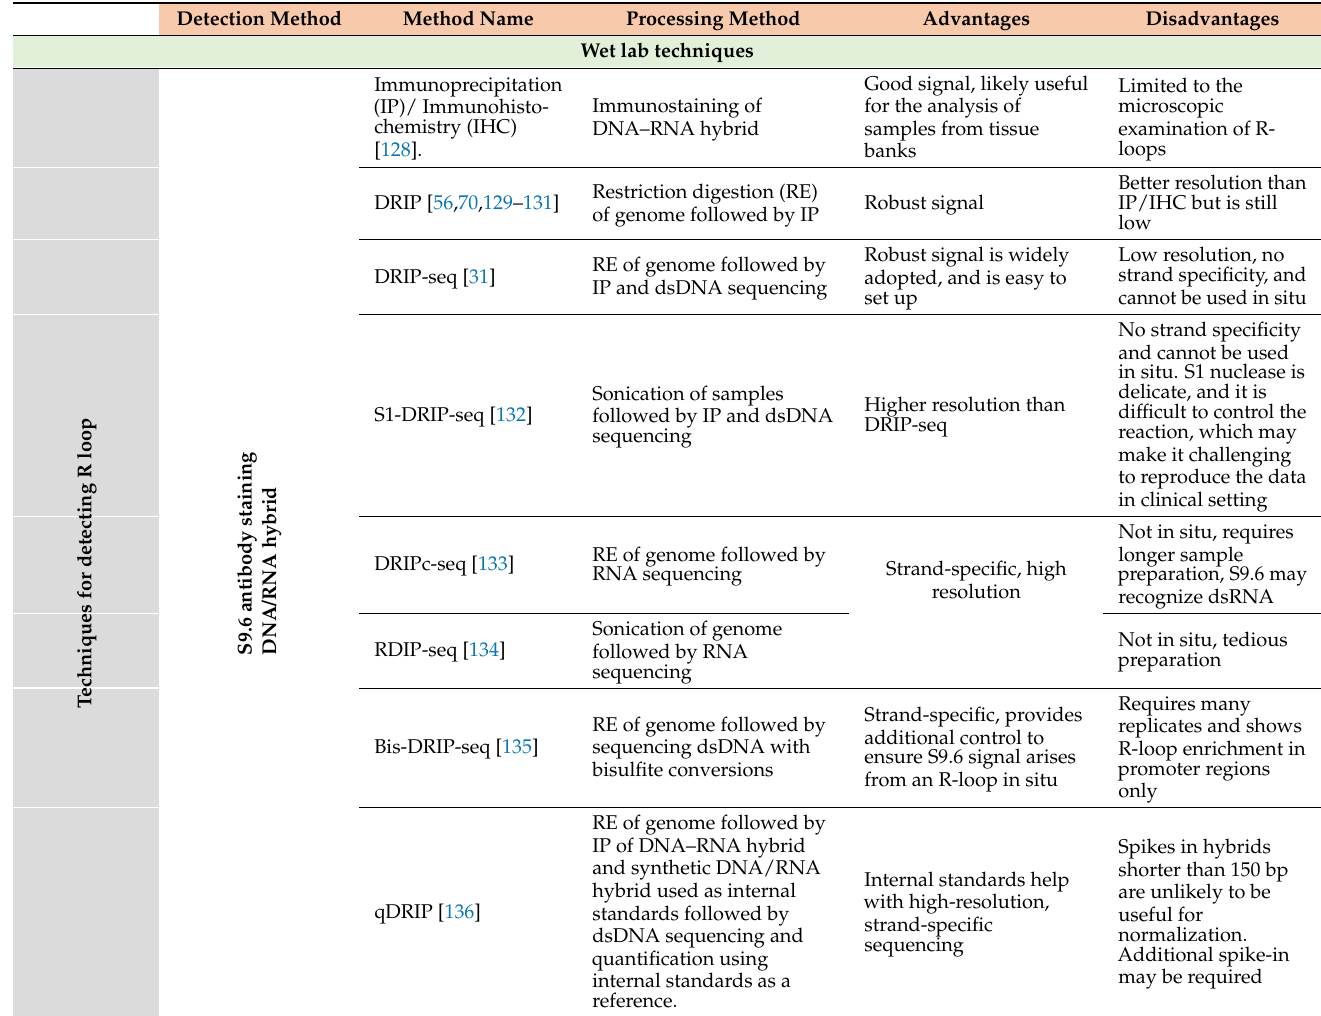
Table 4. Diagnostic tools used to detect R-loops and R-loop-binding